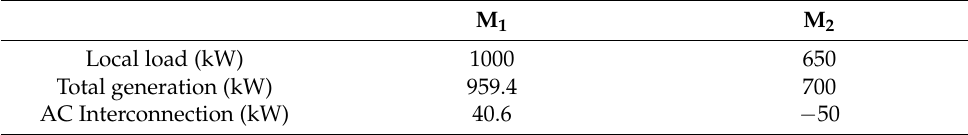
Table 2. Energy balance at a steady state in both